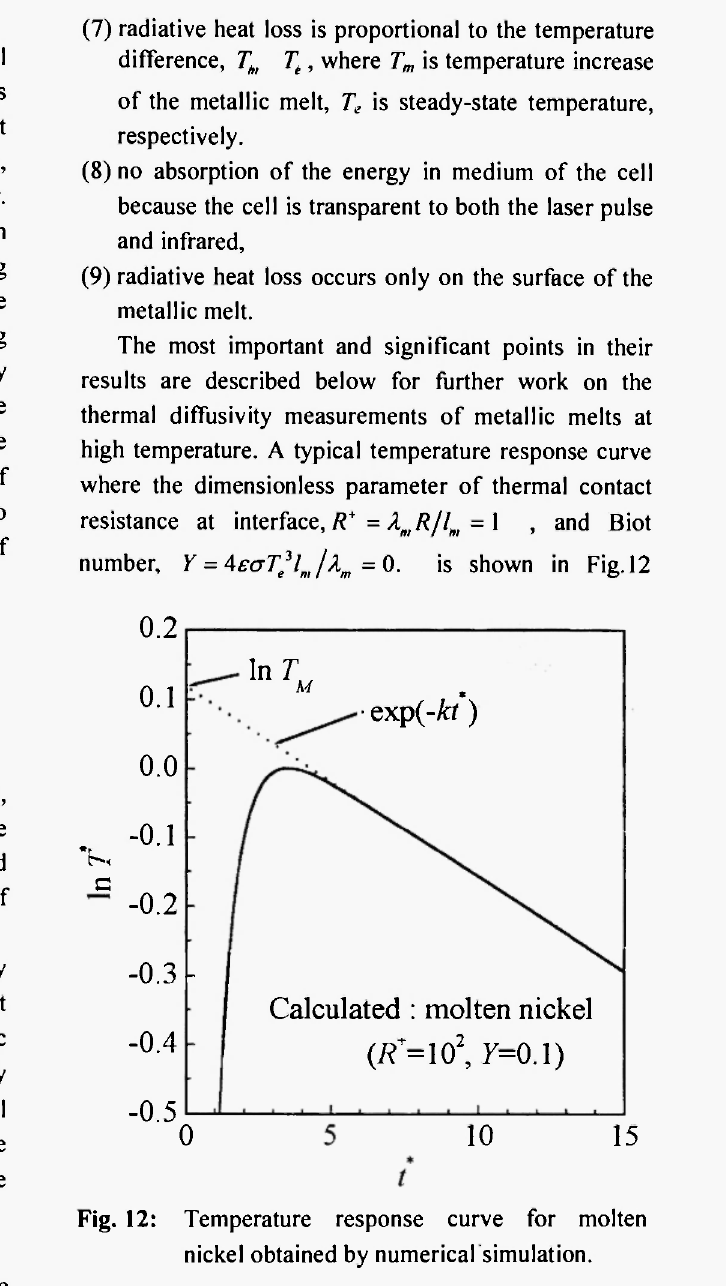
Temperature response curve for molten nickel obtained by numerical